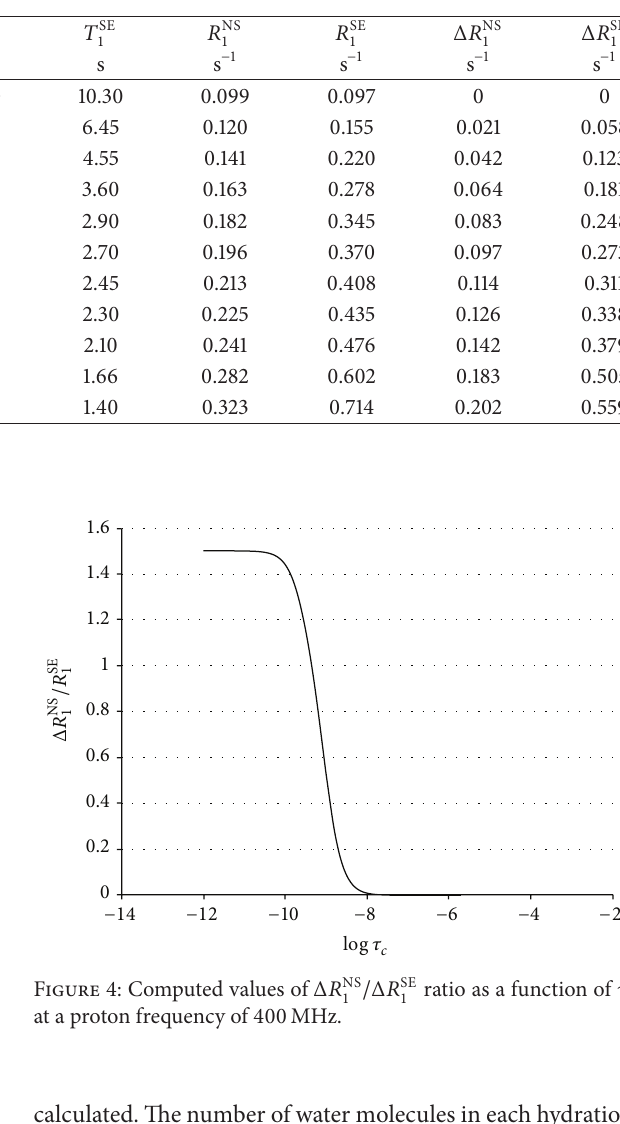
Table 1: Water non-selective and selective proton spin-lattice relaxation times as a function of the human albumin content at 298 K. In the same table the protein contribution to the selective and non-selective proton spin-lattice relaxation rates Δ𝑅 SE